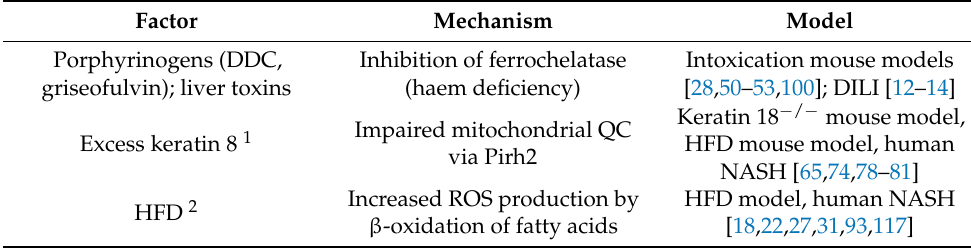
Table 2. Factors that trigger acute mitochondrial damage in the